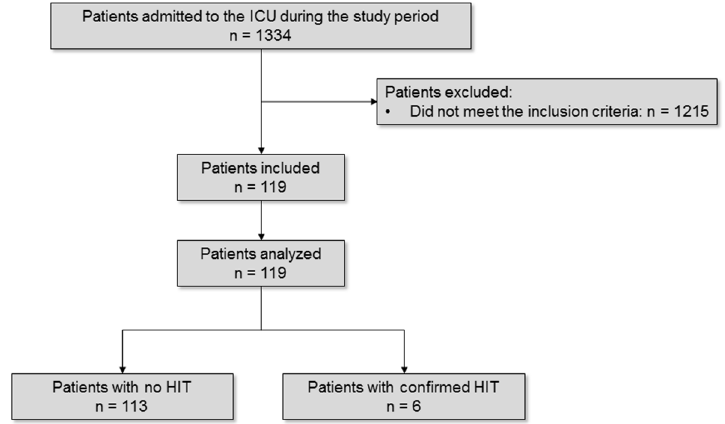
Figure 1. Flow-chart of the study. ICU: intensive care unit; HIT: heparin-induced thrombocytopenia. All final decisions made by the independent committee were unanimous. HIT was suspected from: thrombocytopenia in 73 (61%) patients; thrombosis in 29 (24%) patients; thrombocytopenia and thrombosis in 16 (13%) patients; heparin resistance in 1 (1%) pa- tient. The overall incidence of HIT during the study period was 0.43%. Baseline character- istics and outcomes of patients in the 2 groups, are presented in Table 1. Table 1. Baseline characteristics of the study population.